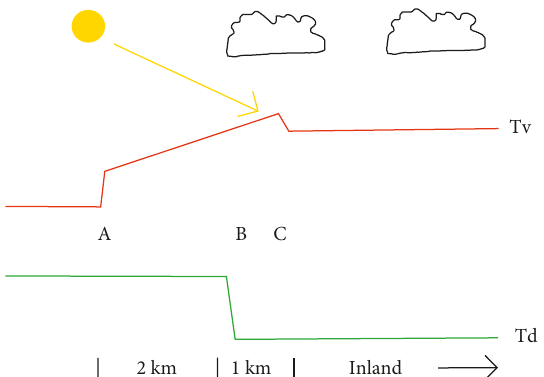
Figure 17: Conceptual schematic summarizing detailed structure of observed passive sea breeze, as described in